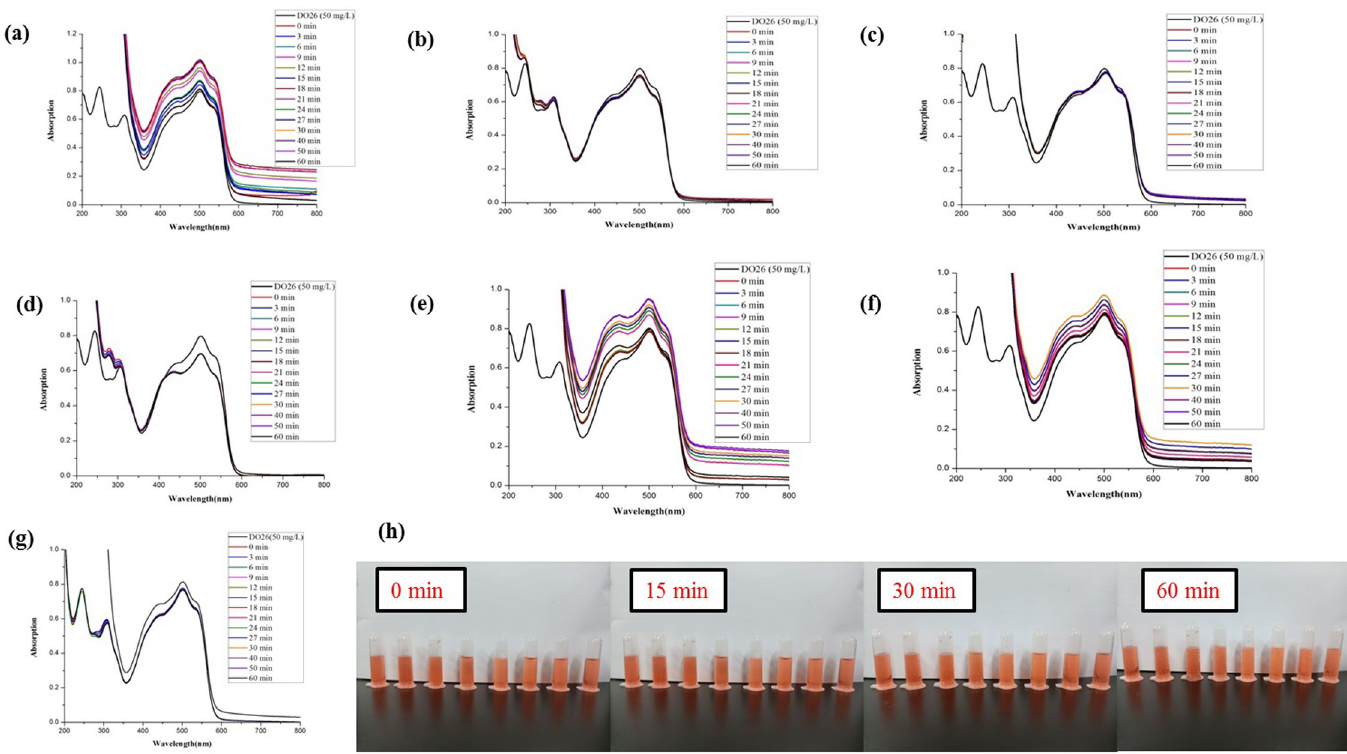
Fig 11. Comparison of the reductive degradation of Direct Orange 26 using different fresh ginger extracts: (a) unpeeled fresh ginger water extract; (b) peeled fresh ginger water extract; (c) fresh ginger peel water extract; (d) unpeeled fresh ginger ethanol extract; (e) peeled fresh ginger ethanol extract; (f) fresh ginger peel ethanol extract; (g) CK; (h) The solution appearance comparison of mixtures different fresh ginger extract and DO26 after reaction for 0, 15, 30 and 60 min. The solutions from left to right are DO26 (50 mg/L), CK, unpeeled fresh ginger water extract, peeled fresh ginger water extract, fresh ginger peel water extract, unpeeled fresh ginger ethanol extract, peeled fresh ginger ethanol extract, and fresh ginger peel ethanol